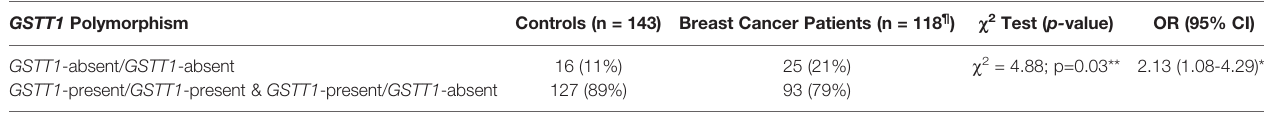
TABLE 3 | Distribution of GSTT1 genotypes in controls, breast cancer patients, and the association analysis with breast cancer risk*.